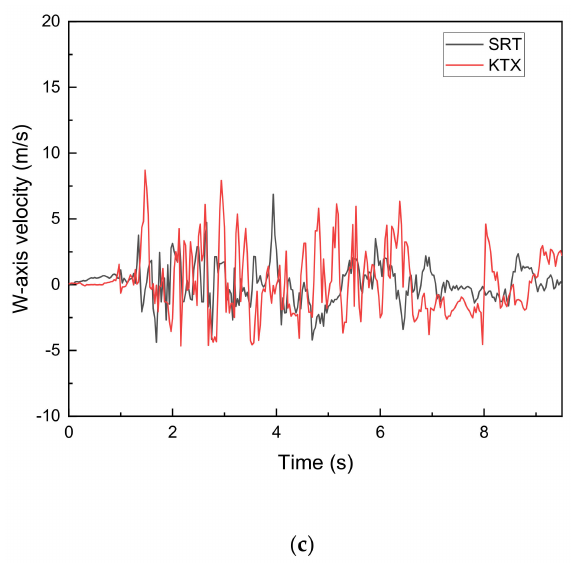
Figure 5. Train-induced wind velocity over time measured at 0.8 m from the train surface in each